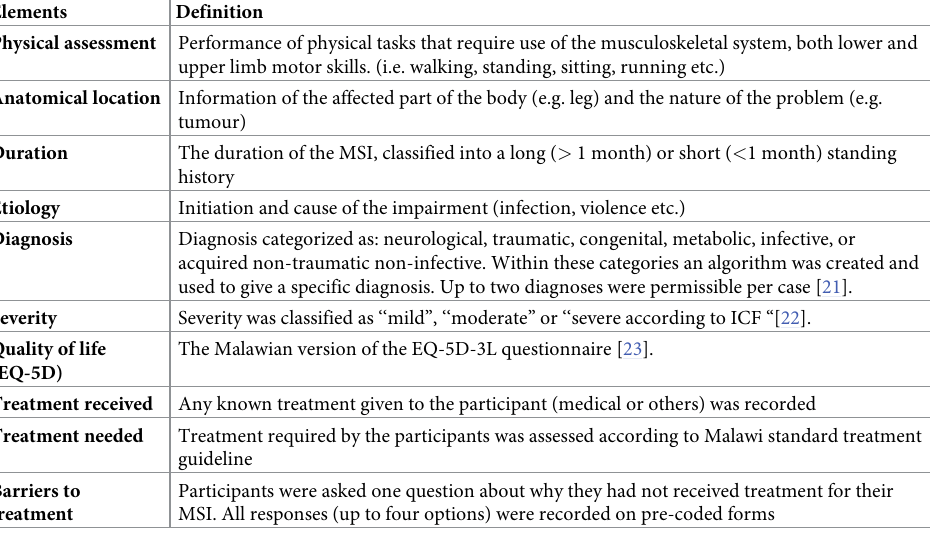
Table 2. Standardized interview and examination protocol.